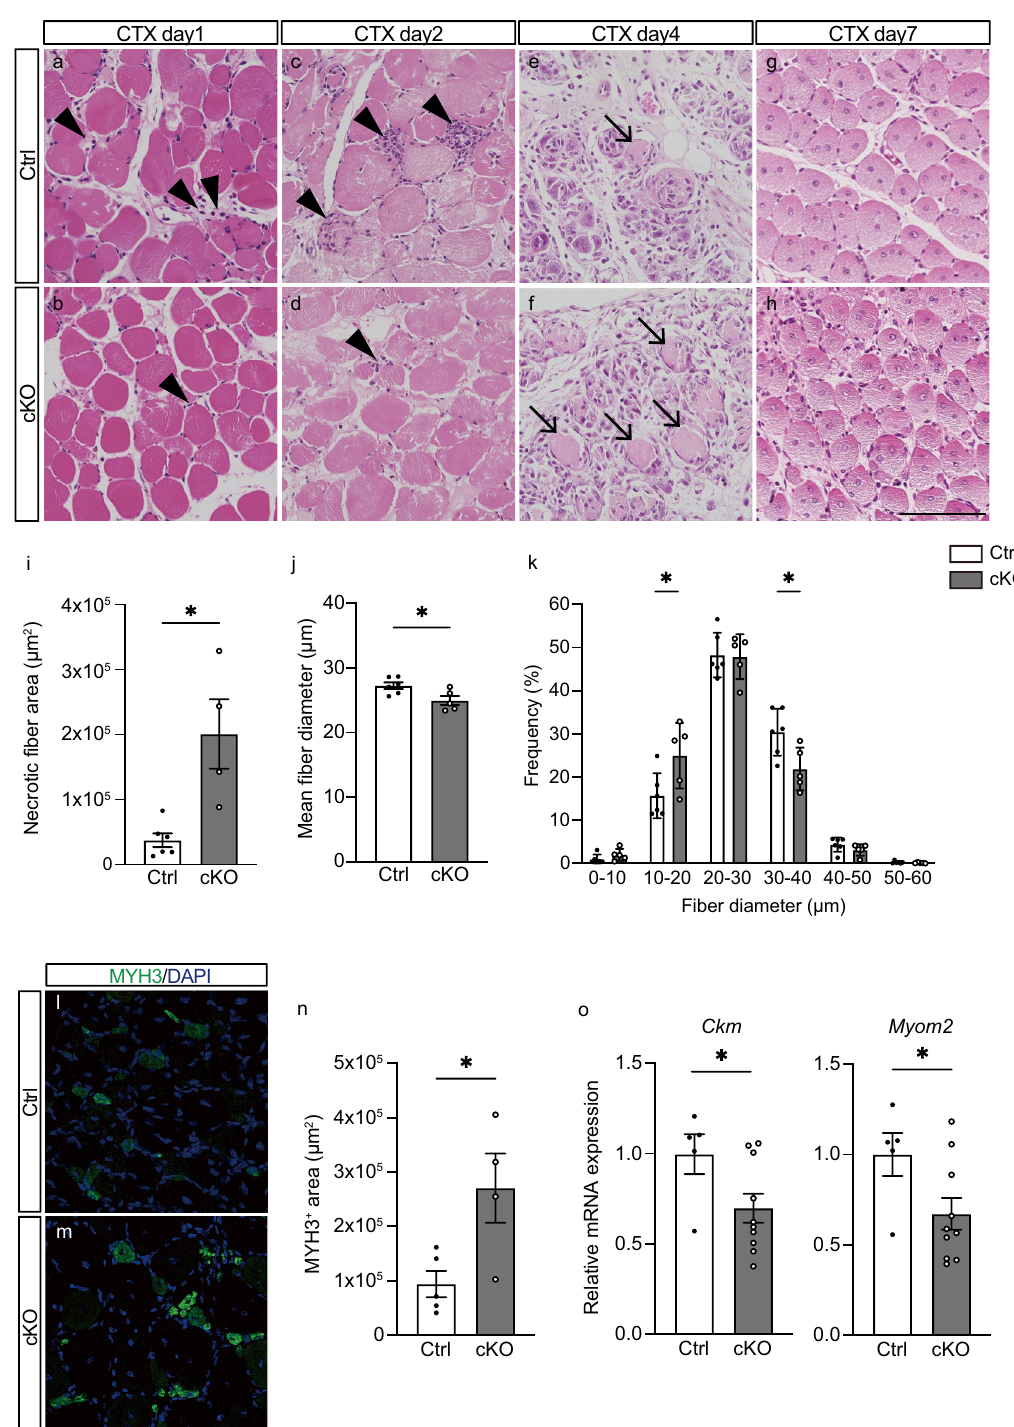
Figure 2. Arntl deletion from myeloid cells induces abnormal muscle regeneration. ( a – h ) Hematoxylin/eosin staining of Ctrl and cKO tibialis anterior (TA) muscles on days 1 ( a , b ), 2 ( c , d ), 4 ( e , f ), and 7 ( g , h ) after cardiotoxin (CTX) injury. Arrowheads indicate infiltration of inflammatory cells into the muscle on days 1 and 2 post-injury. Arrows indicate necrotic myofibers in the muscle 4 days post-injury. Representative images from Ctrl (n = 4) and cKO (n = 4) muscles on day 1, Ctrl (n = 4) and cKO (n = 4) muscles on day 2, Ctrl (n = 6) and cKO (n = 4) muscles on day 4, and Ctrl (n = 6) and cKO (n = 5) muscles on day 7. ( i ) Quantification of necrotic myofiber area of Ctrl (n = 6) and cKO (n = 5) TA muscles on day 4 post-injury. ( j ) Mean myofiber diameter in Ctrl (n = 6) and cKO (n = 5) TA muscles on day 7 post-injury. ( k ) Myofiber diameter distributions in Ctrl (n = 6) and cKO (n = 5) TA muscles on day 7 post-injury. ( l , m ) Immunostaining for myosin heavy polypeptide 3 (MYH3, green) and DAPI staining of nuclei (blue) in Ctrl (n = 5) and cKO (n = 4) TA muscles on day 7 post-injury. ( n) Quantification of MYH3-positive area in Ctrl (n = 5) and cKO (n = 4) TA muscles on day 7 post- injury. ( o) RT-PCR assessment of creatine kinase, muscle ( Ckm ) and myomesin 2 ( Myom2 ) expression in TA muscles from Ctrl (n = 5) and cKO (n = 10) mice on day 7 post-injury. Data are expressed as the means ± SEM. * p < 0.05 with unpaired two-tailed Student’s t -test ( i , j , n , o ) or two-way ANOVA with Bonferroni’s multiple comparisons test ( k ). Scale bar = 100